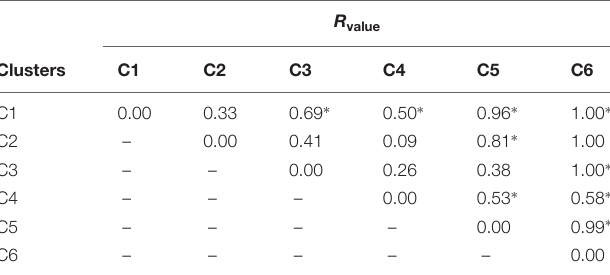
TABLE 2 | Analysis of similarity (ANOSIM) for microbial community structure and clusters formation for 19 sewage sludges from São Paulo State,